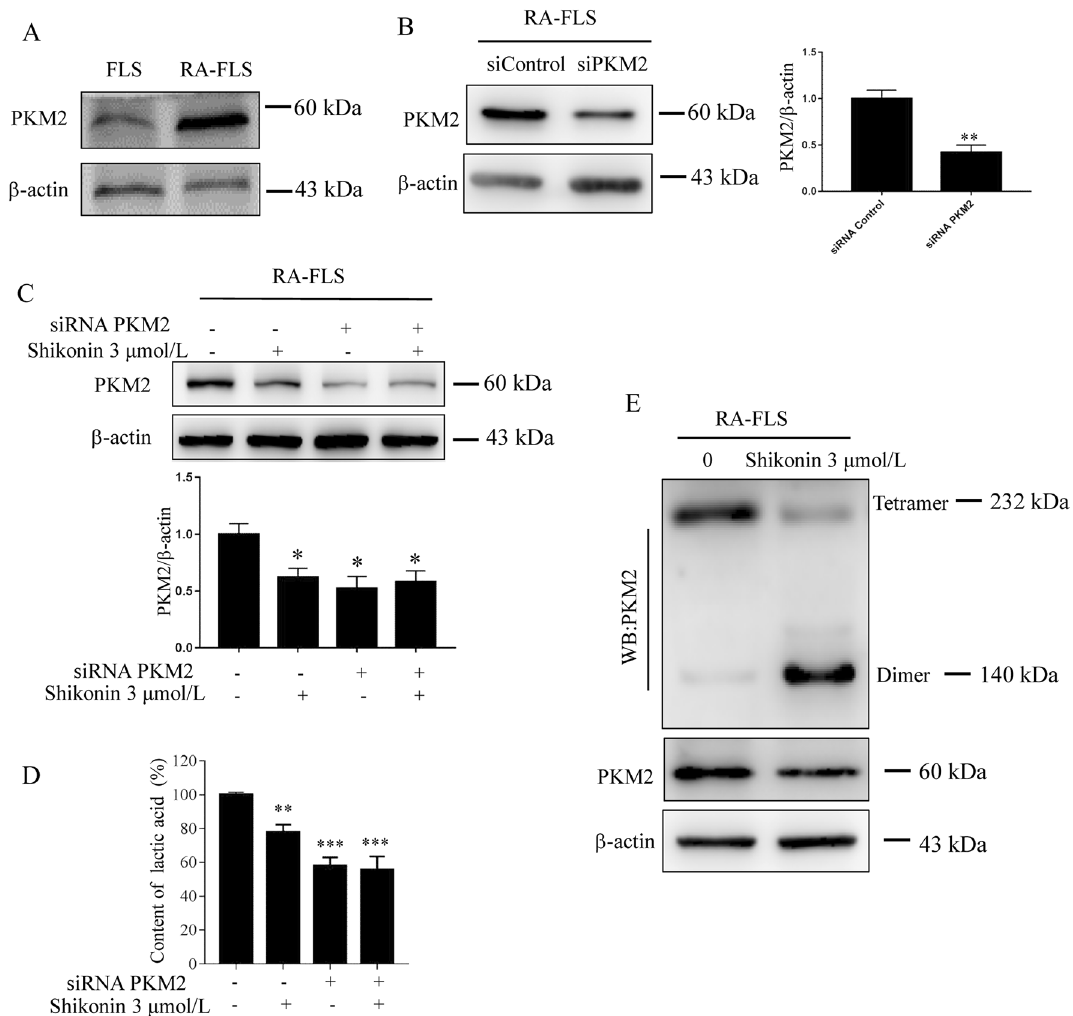
Figure 2. PKM2 plays a critical role in energy metabolism in RA-FLSs. ( A ) Western blot analysis of PKM2 protein expression in RA-FLSs and FLSs. ( B , C ) Western blot analysis of PKM2 protein expression in RA-FLSs treated as indicated (siRNA Control, siRNA PKM2). ( D ) Intracellular lactic acid changes detected by using a lactic acid kit when PKM2 was knocked down in RA-FLSs. ( E ) PKM2 tetramer vs . dimer formation after shikonin exposure for 24 h in RA-FLSs. * p < 0.05, ** p < 0.01 vs Control group. Data are representative of at least three independent